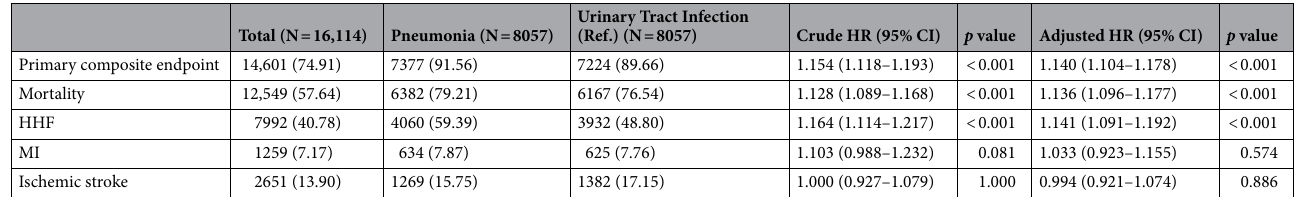
Table 3. Clinical outcome of pneumonia versus urinary tract infection group. Model was adjusted for age, sex, comorbidities, procedure history, medication history. HR hazard ratio, HHF hospitalization for heart failure, MI myocardial